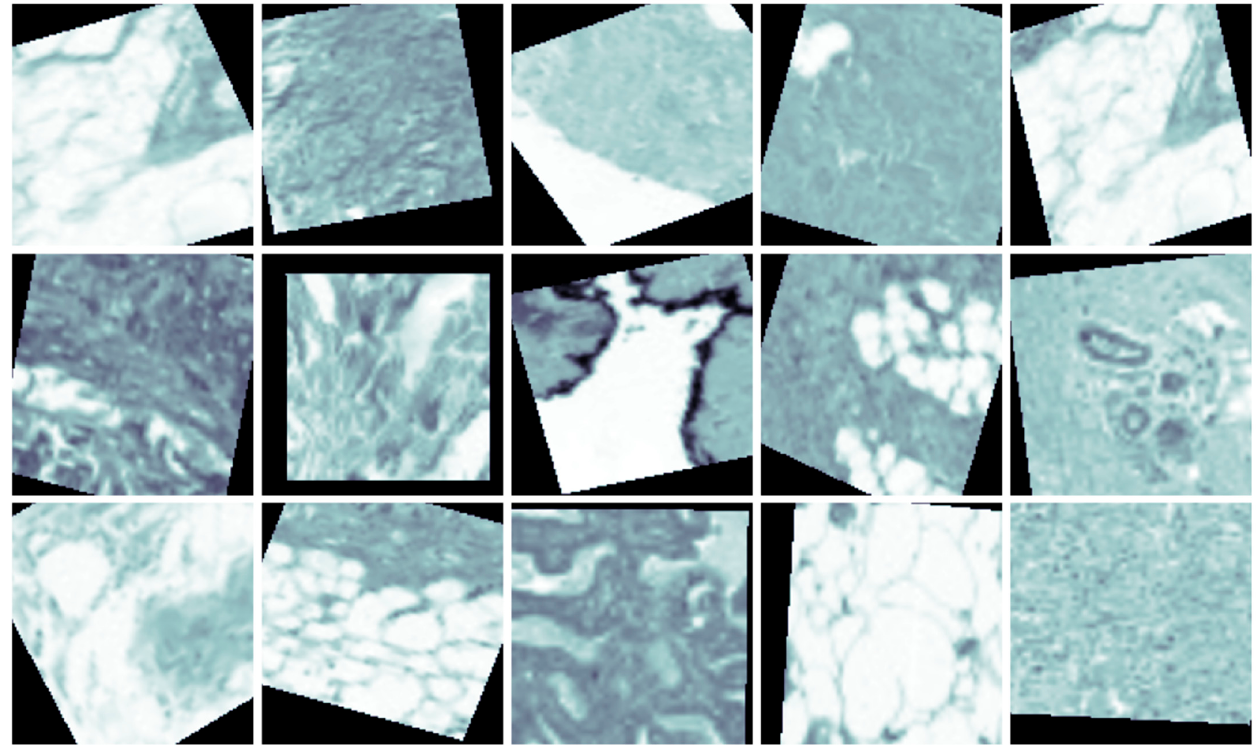
Figure 5. Dataset samples after the application of data augmentation methods.